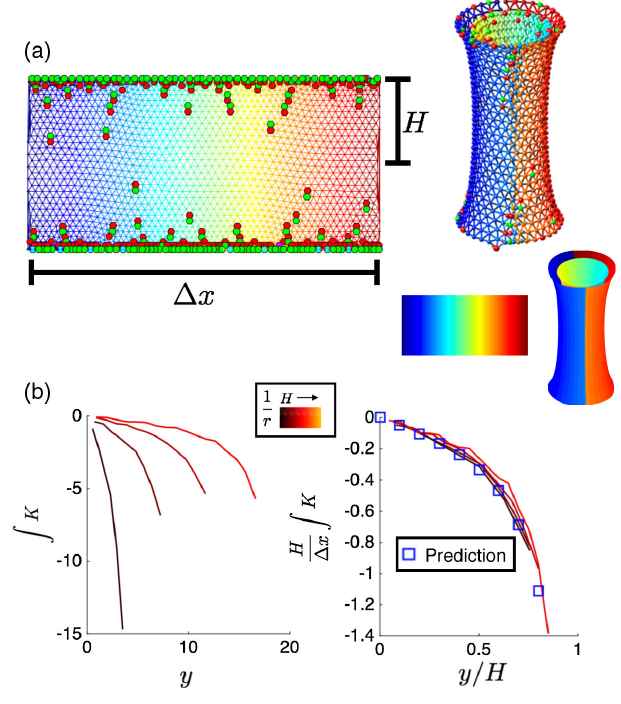
FIG. 5. Simulated hard-wall confined crystal with corre- sponding negatively curved surface. (a) Translationally symmetric hard-wall boundary. An example low-energy con- figuration of Coulomb-repulsive particles confined inside a hard-wall boundary is shown next to the corresponding uniform curved crystal. Embedding the entire structure re- quires covering the surface multiple times (see Appendix E). In order to separate the different coverings, the surface is slightly distorted. (b) Integrated curvature, which collapses when rescaled by the system